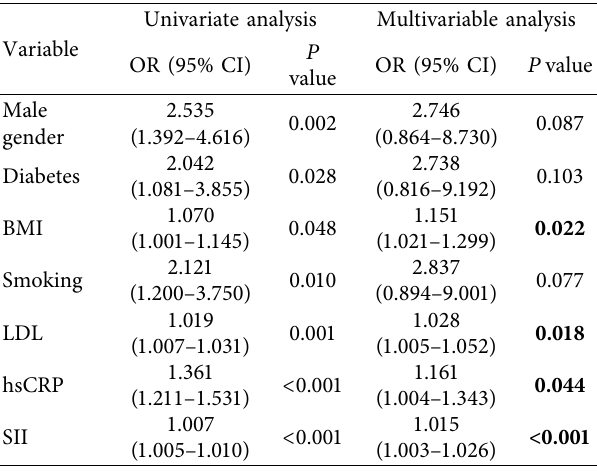
Table 3: Univariate and multivariable logistic regression analyses for predicting coronary slow fow.